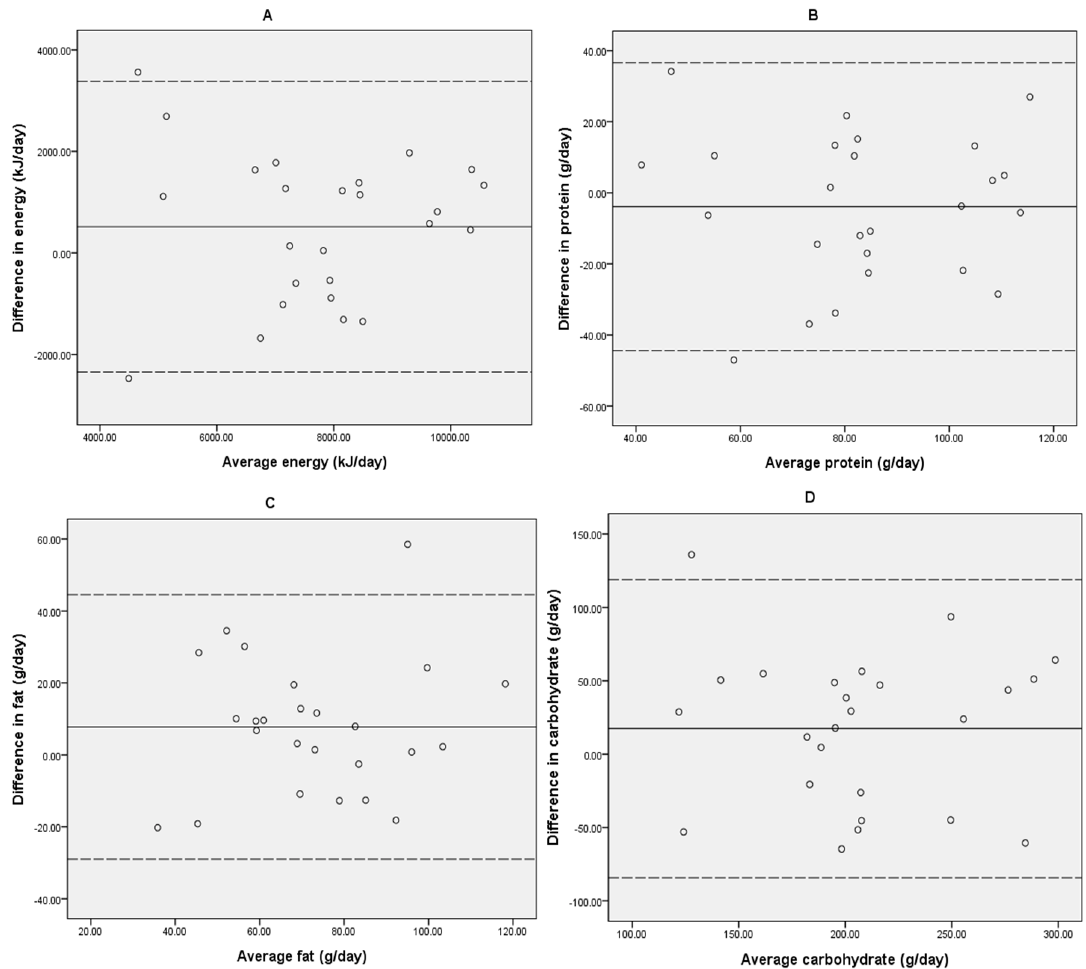
Figure 2. Bland-Altman plots showing mean difference (24-R − DietBytes, solid line) vs. mean intakes ((24-R + DietBytes)/2) between the DietBytes image-based dietary records and 24-R nutrient intakes, and two standard deviations of the difference (limits of agreement, dotted lines), for the following: ( A ) Energy (kilojoules per day); ( B ) Protein (grams per day); ( C ) Fat (grams per day); ( D ) Carbohydrate (grams per day).